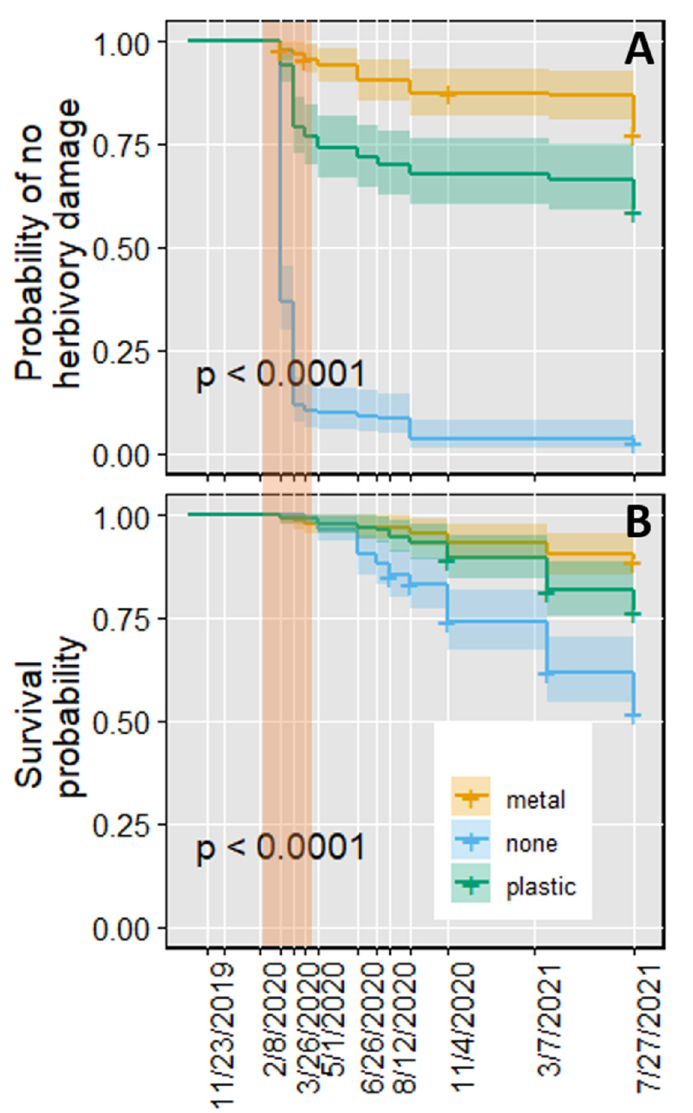
Figure 4. Herbivory damage and survival of Artemisia tridentata seedlings outplanted in October 2019. Probability of no herbivory damage ( A ) and survival ( B ) under the different tree protector treatments. The shaded area in ( A , B ) indicates the period of major herbivory. Curves in ( A , B ) are medians and 95% confidence intervals.